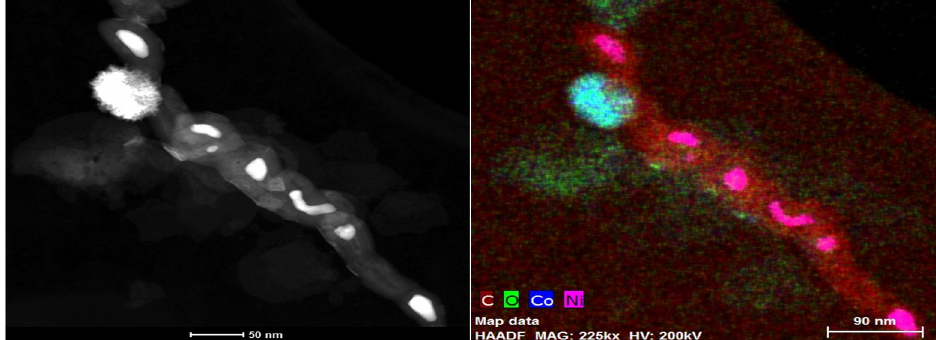
Figure 3. TEM of cobalt oxide decorating MWCNTs and elemental mapping.